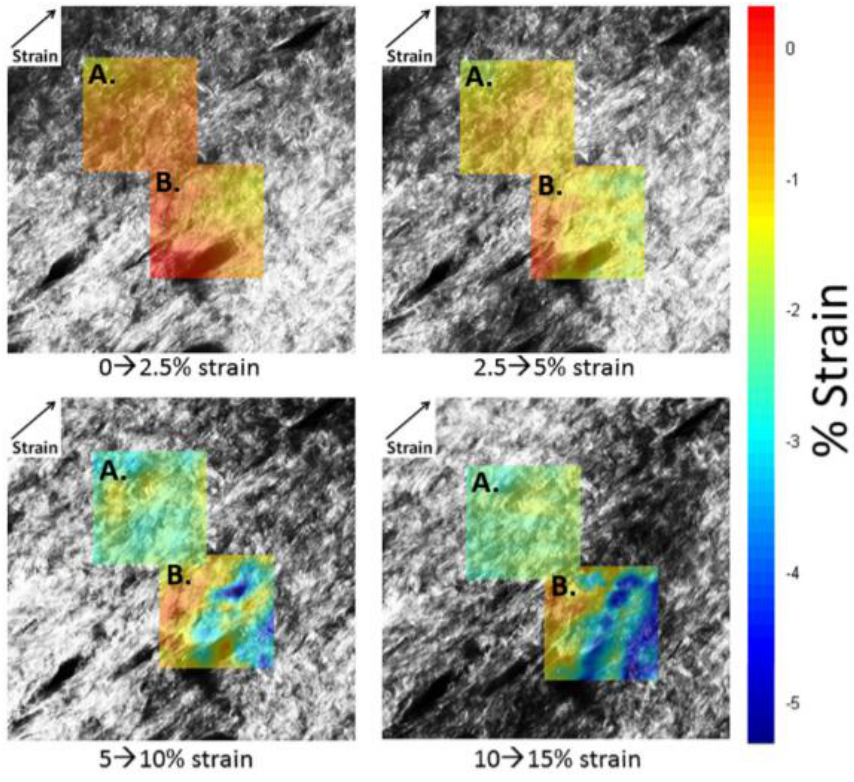
Figure 7. Minimum principal strain maps for matrix region ( A ) and hair follicle region ( B ). Percent strain is given as the difference between images as indicated. Strain direction is indicated in the upper left corner.